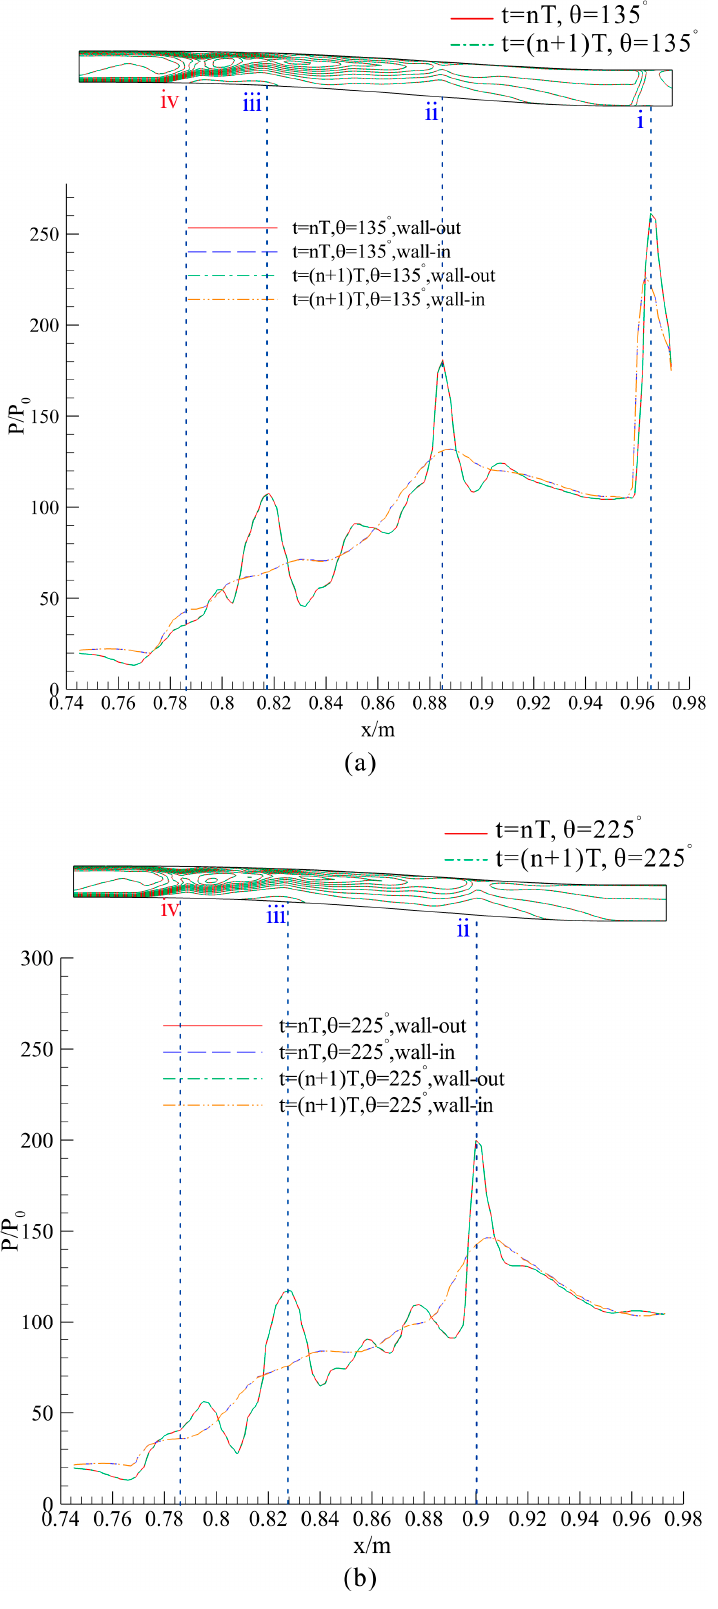
Figure 14. Comparison of the Mach number and pressure profiles of the meridian planes in adjacent cycles. ( a ) θ = 135°. ( b ) θ = 225°.